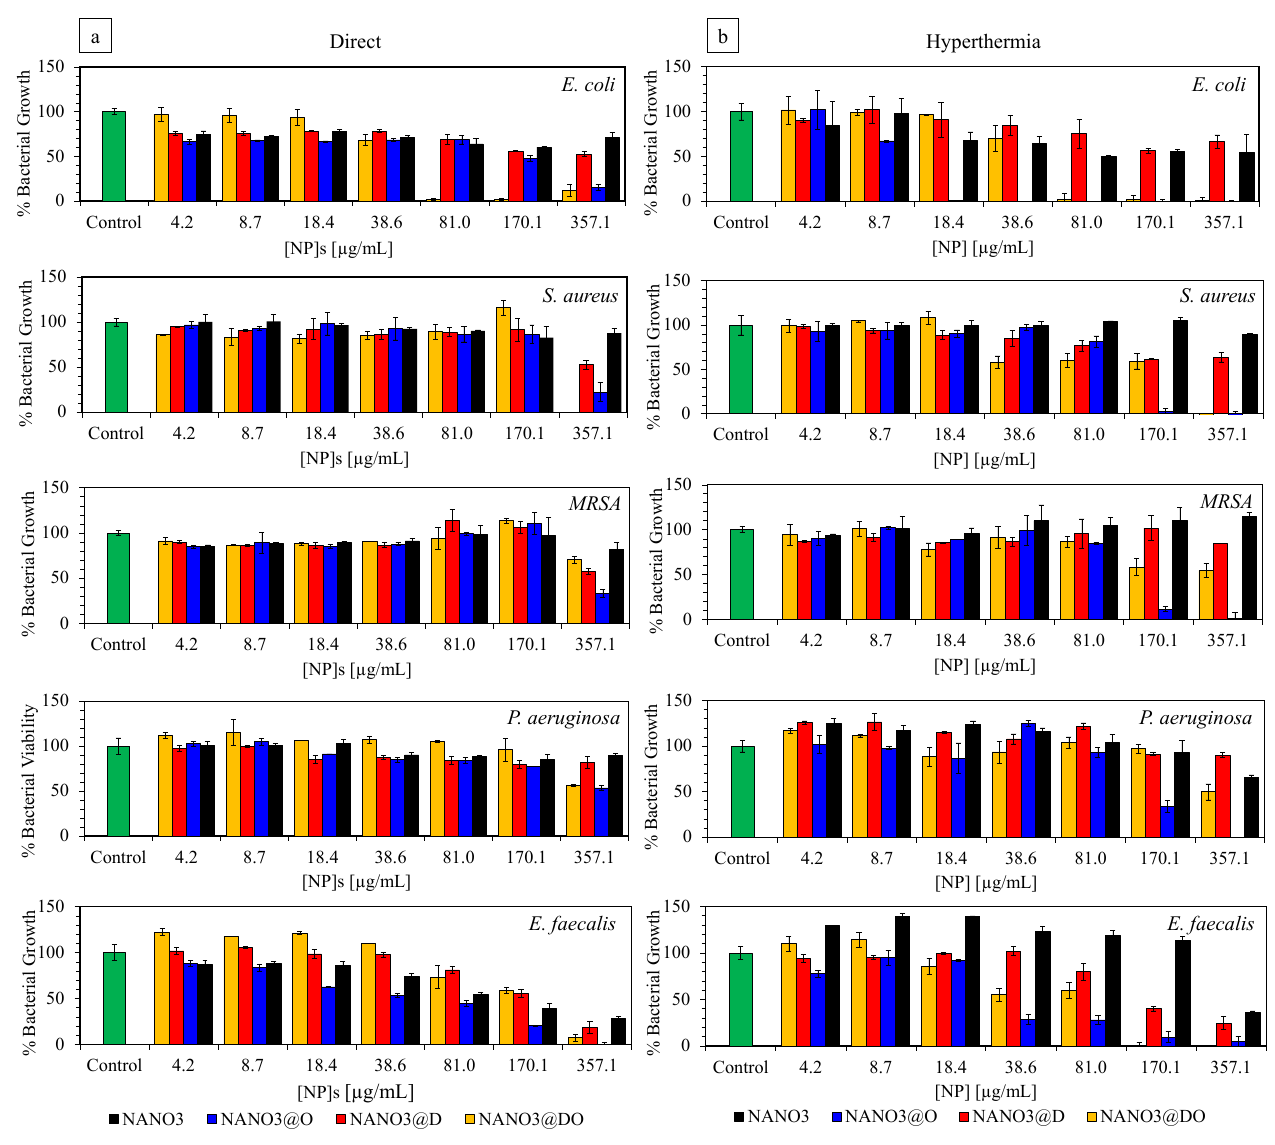
Figure 6. Inhibitory activity, as bacterial growth (%), of NANO3, NANO3@O, NANO3@D and NANO3@DO against ( from top to bottom ) E. coli , S. aureus , MRSA, P. aeruginosa and E. faecalis strains, by direct application ( a ) and after-hyperthermia (AMF of 274 kHz) application ( b ). Concentrations given as µ g of nanoparticle per